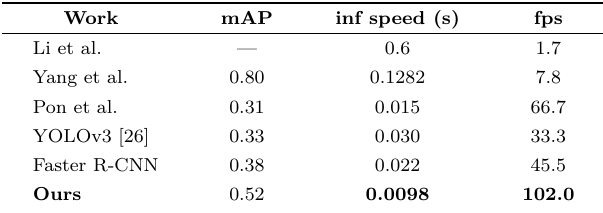
Efficiency of state-of-the-art methods. Our proposed framework boosts the highest inference speed by 35%, while outperforming the work of Pon et